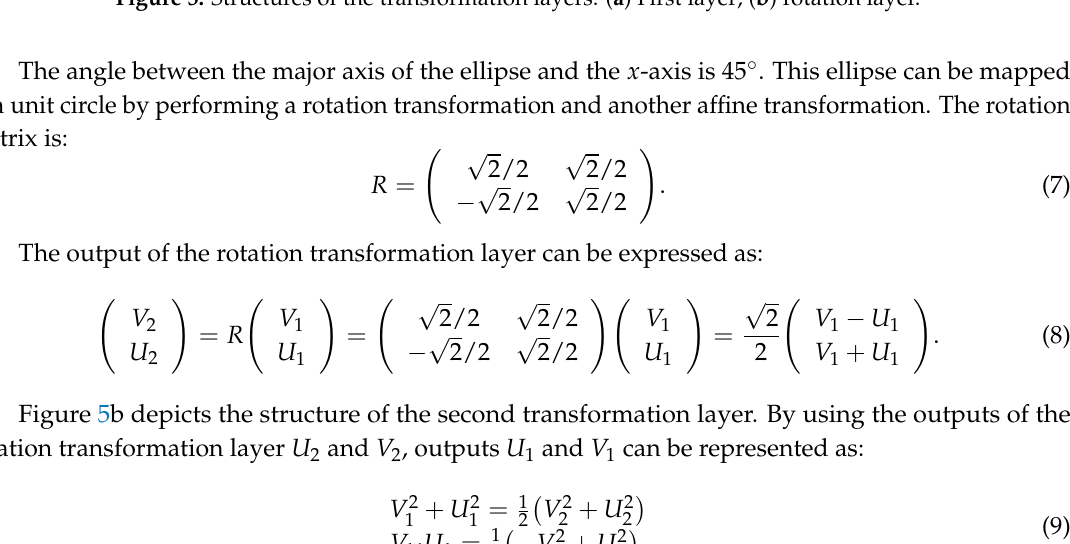
Figure 5. Structures of the transformation layers. ( a ) First layer; ( b ) rotation layer.